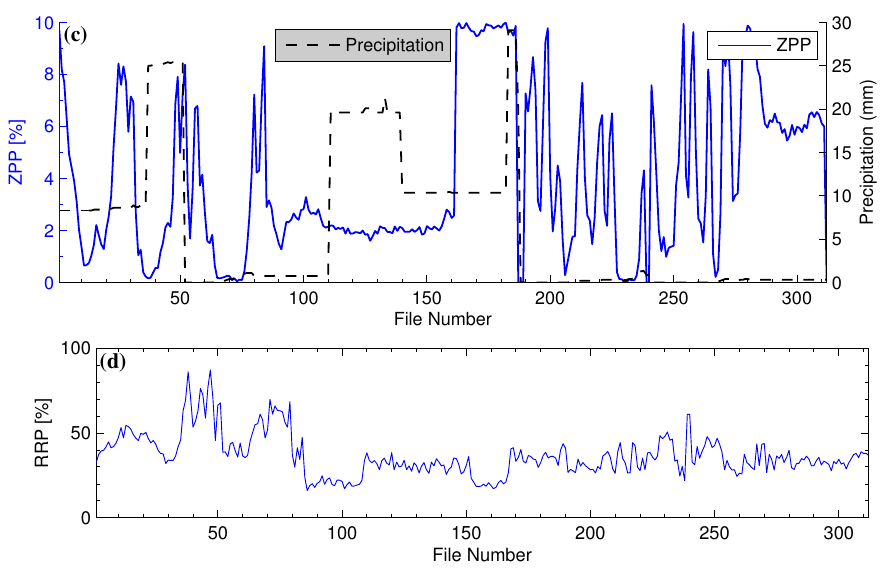
Figure 4. Results: ( a ) wind speed; ( b ) wind direction; ( c ) zero pixel percentage (ZPP) and precipitation; ( d ) rain rejection percentage (RRP). The vertical black line in ( a , b ) separates the two data collection periods specified in Table 1. Table 2. Wind speed and direction recovery error statistics: bias and standard deviation